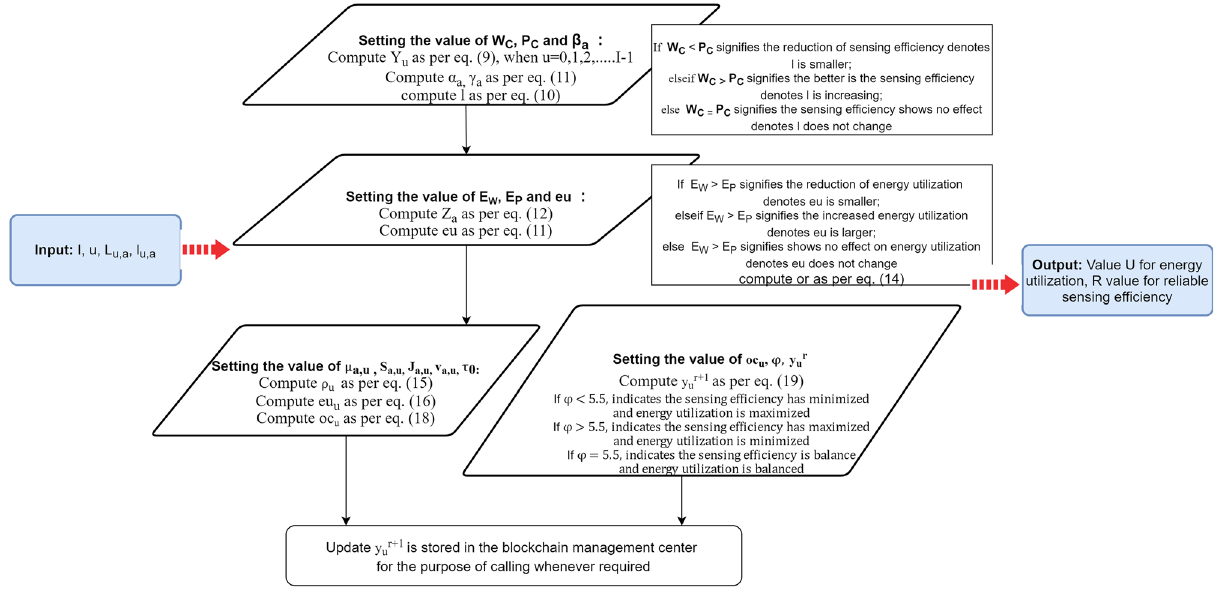
Figure 4. Flowchart for the evaluation and interpretation of